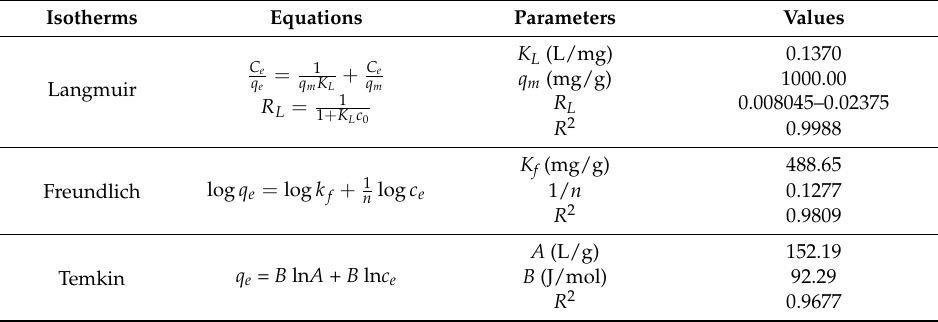
Table 7. The isotherm parameters for adsorption of Malachite Green (MG) onto nanoscale zerovalent zinc (nZVZ).